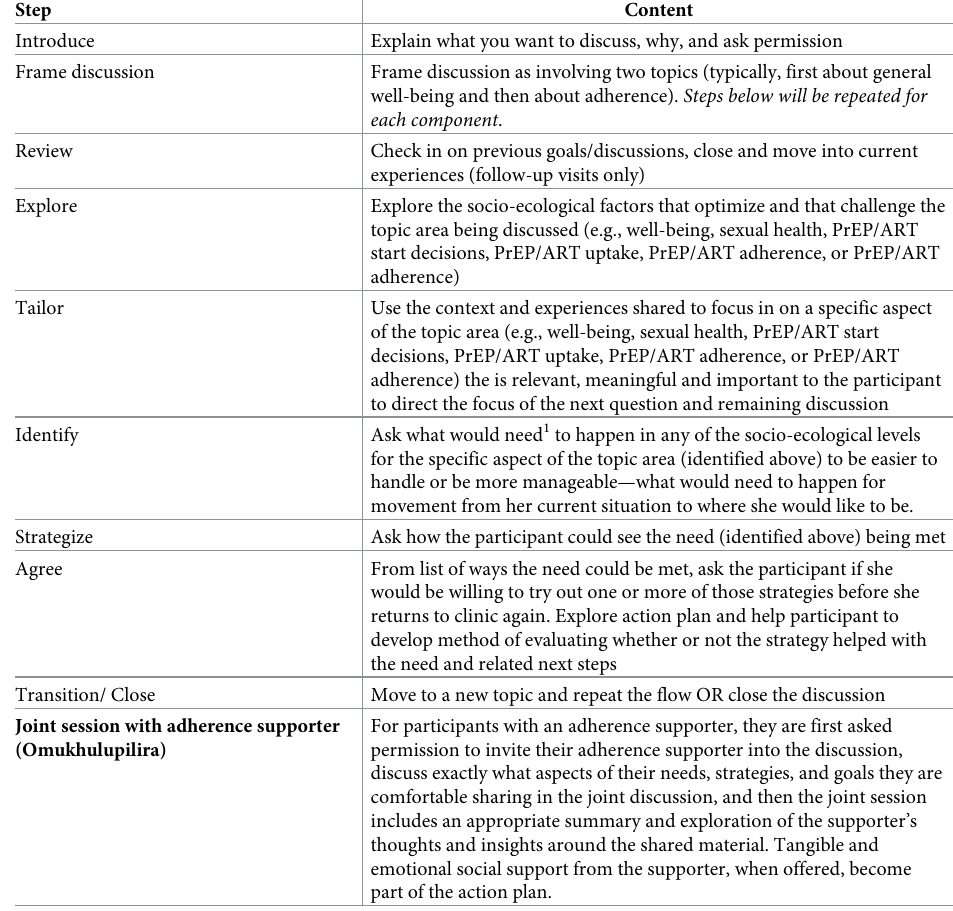
Table 3. Overview of Integrated Next Step Counseling (iNSC)